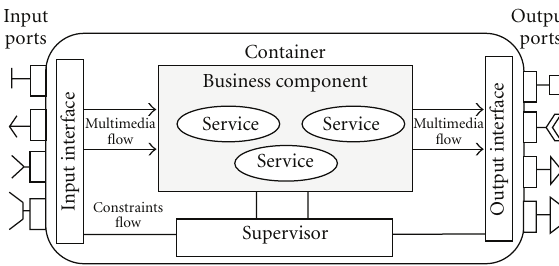
Figure 13: Multimedia component model.